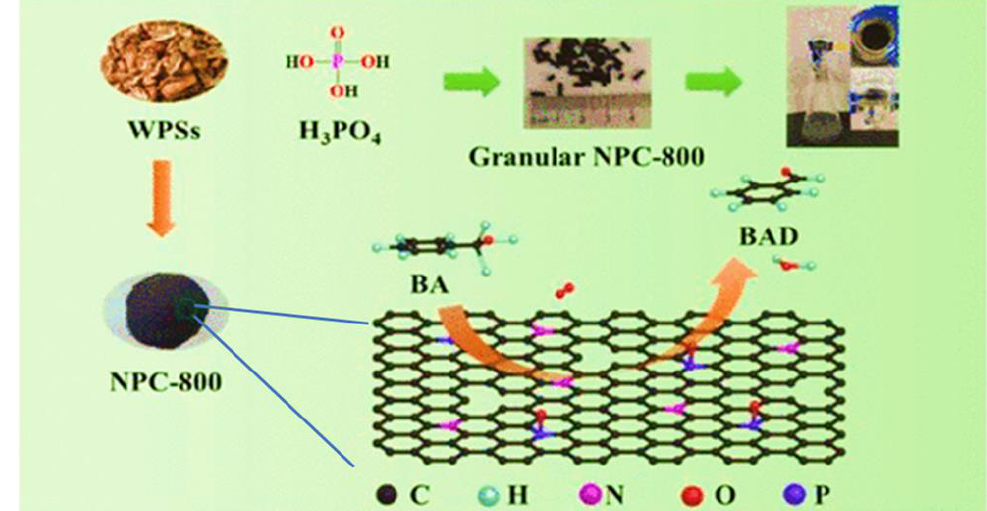
Figure 23. P-doped porous carbon catalysts from waste peanut shells with inherent N functionality and their application in metal-free aerobic alcohol oxidation. Adapted with permission from ref. [126].